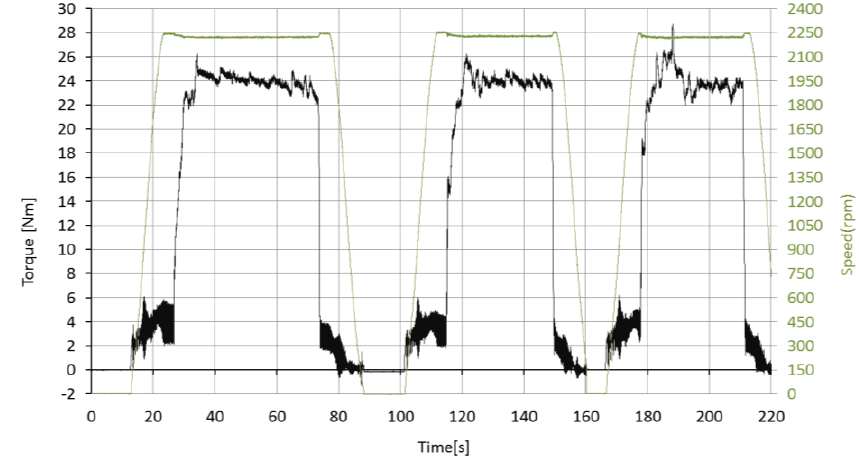
Figure 14. Test cycles. Speed and output torque.